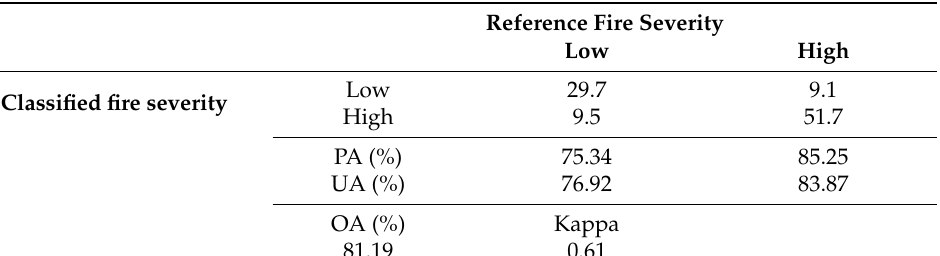
Table 2. Random Forest (RF) classification performance evaluated through the average confusion matrix computed across 10-fold cross-validation resamples. We calculated the overall accuracy (OA), Kappa index, and user’s (UA) and producer’s (PA) accuracy (%).